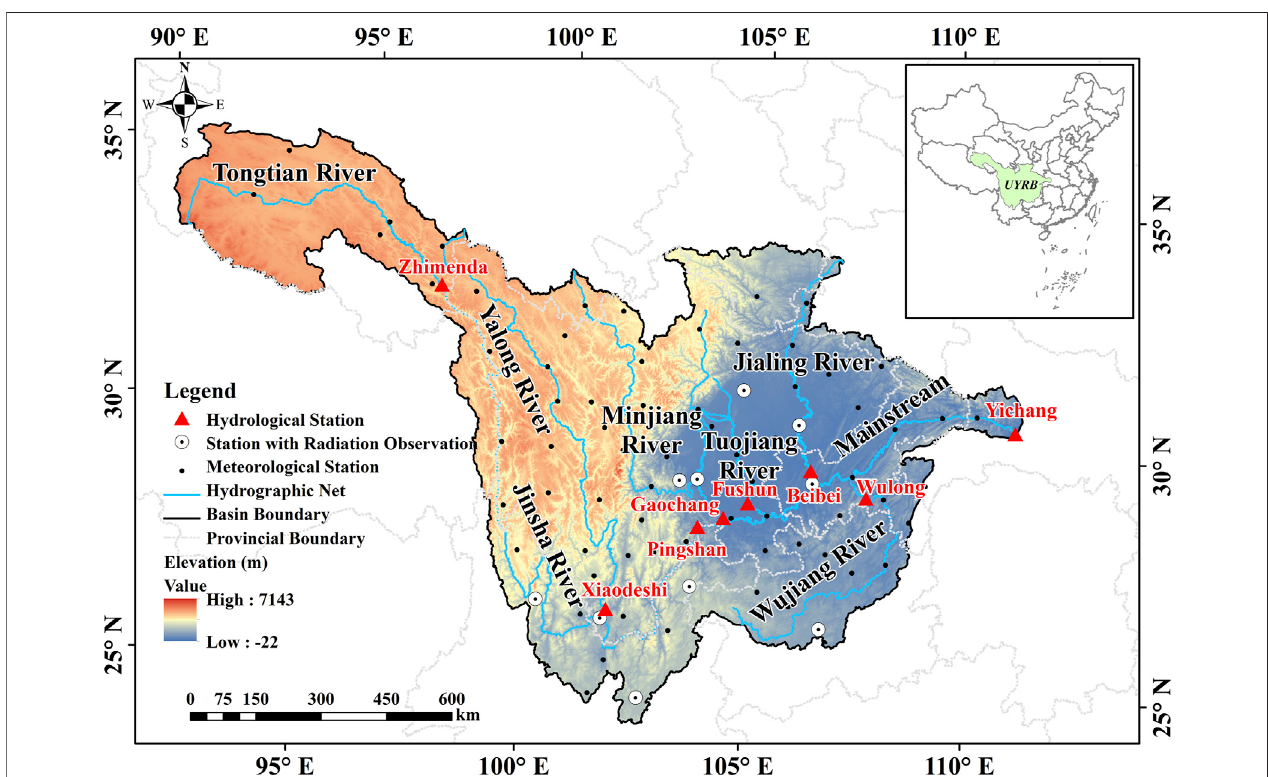
FIGURE 2 | Map of the